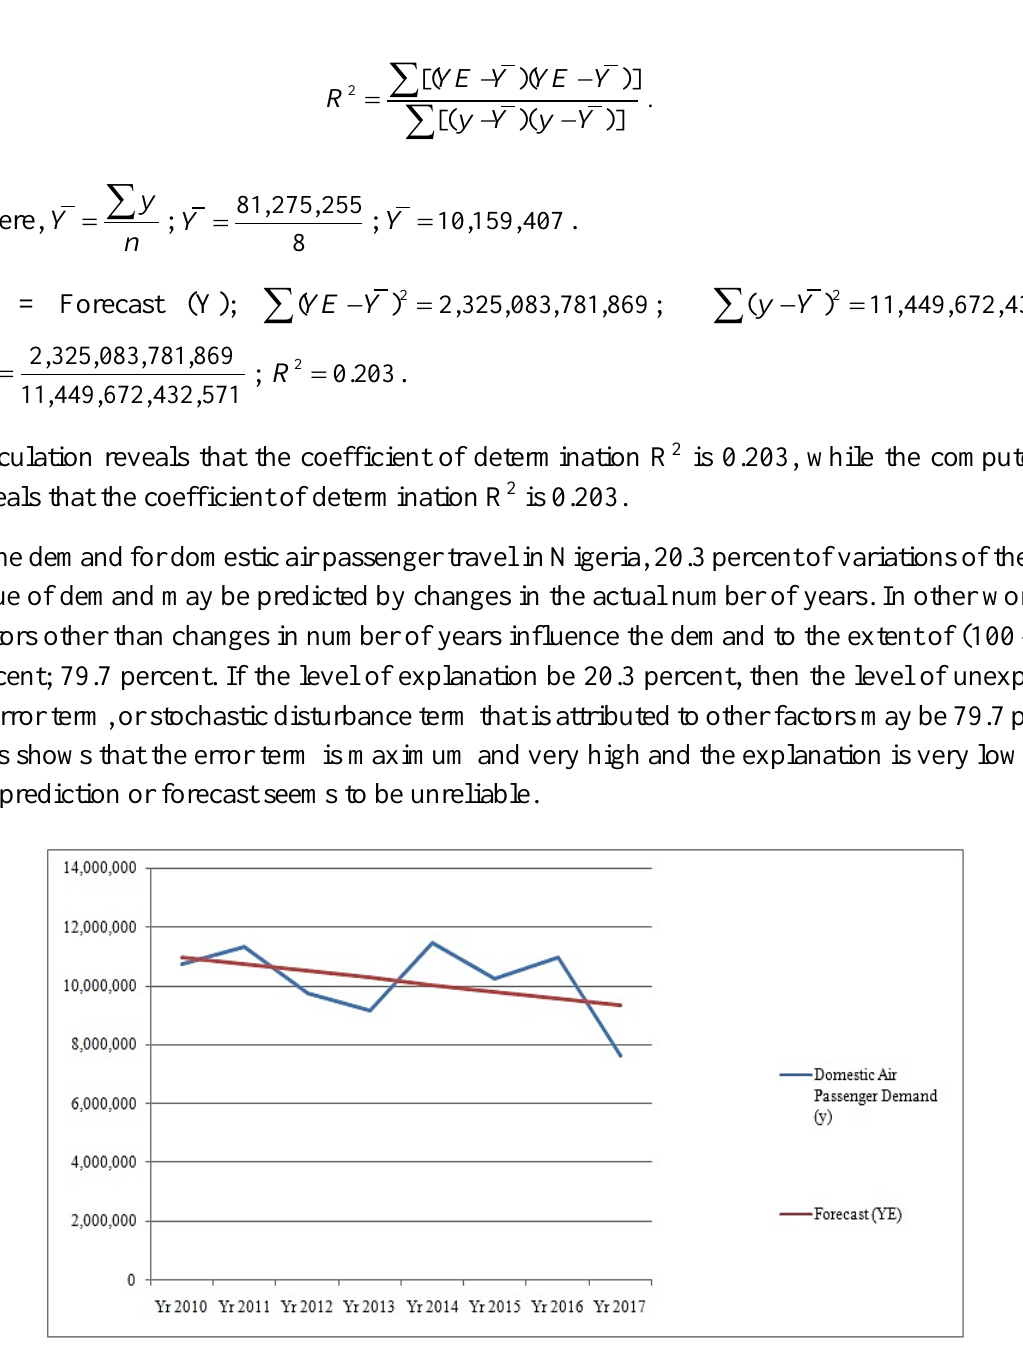
Figure 3. Difference between the True Line and the Observed Line for